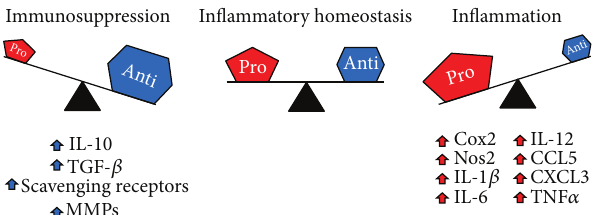
Figure 1: Tissue-resident macrophages are important for maintaining a state of inflammatory homeostasis. Under normal conditions, pro- and anti-inflammatory signals are maintained in a balanced state referred to as inflammatory homeostasis (center). During the early stages of infection or tissue damage, increased production of proinflammatory factors can tip the balance towards an overall inflammatory state (right). During late stages of infection and wound healing, the production of anti-inflammatory factors is significantly increased, leading to an immunosuppressive state (left). A failure to return to inflammatory homeostasis leads to chronic inflammation or immunosuppression and can lead to the development of numerous pathologies, including